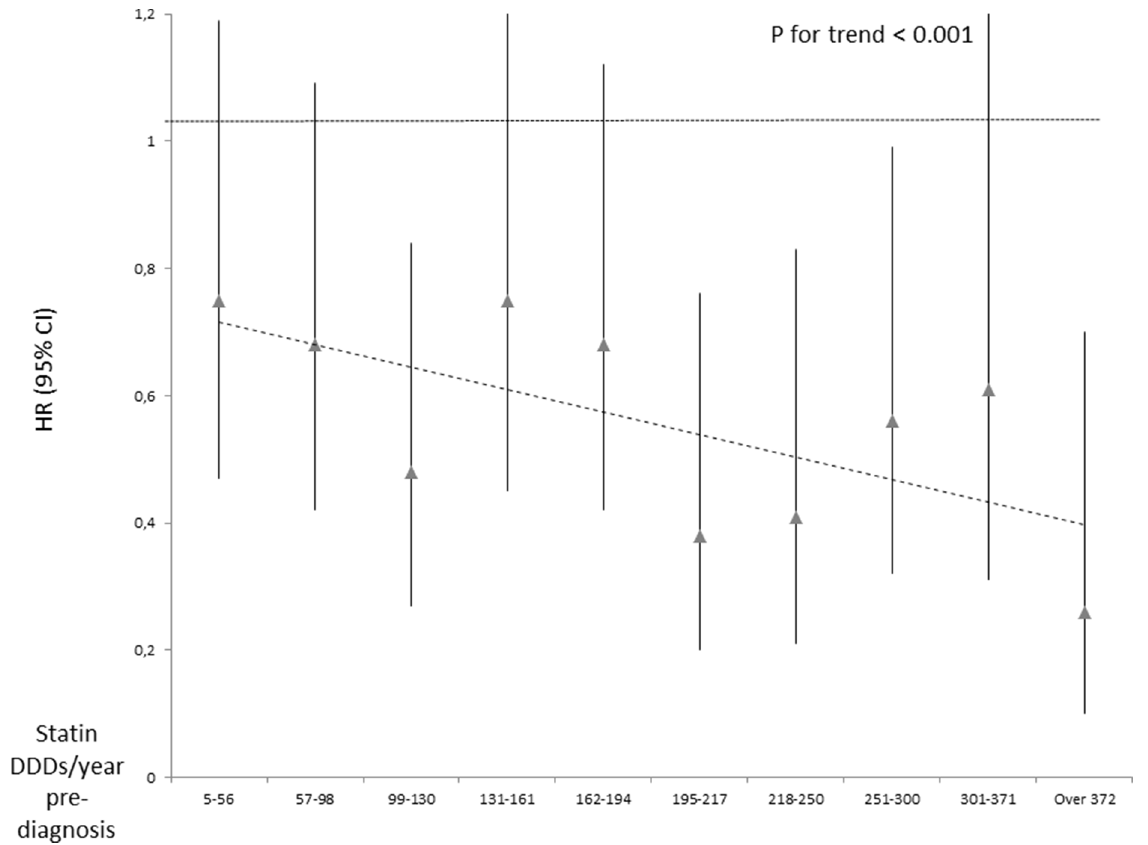
Figure 2. Trend in breast cancer mortality by intensity (doses/year) of pre-diagnostic statin use. Nationwide cohort of all female breast cancer patients in Finland during 1995–2003.